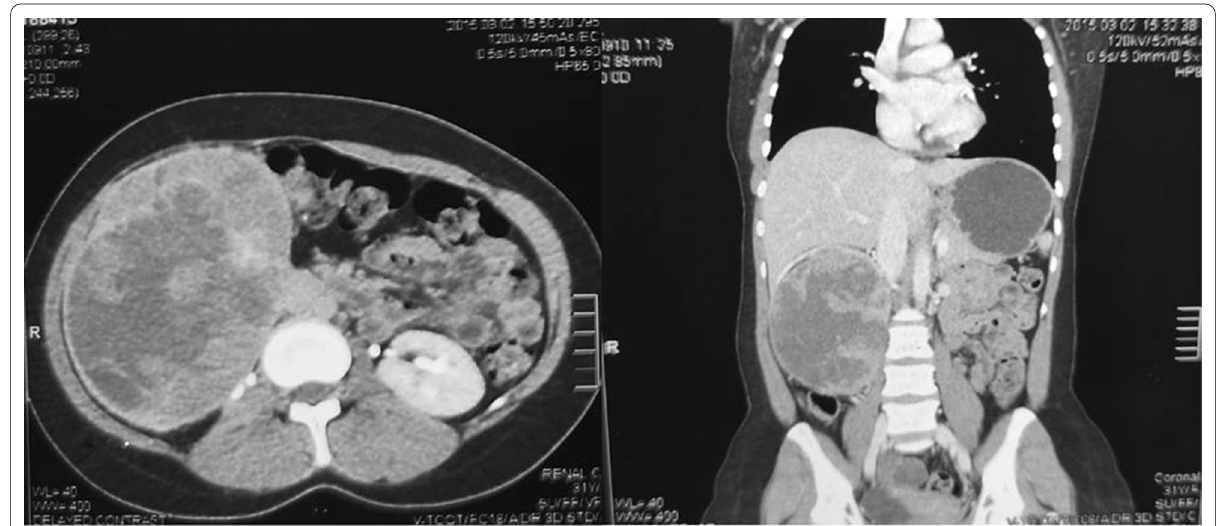
Fig. 1 Contrast‑enhancing CT images of the abdomen showing a huge, well delineate, heterogeneously enhancing mass of the right